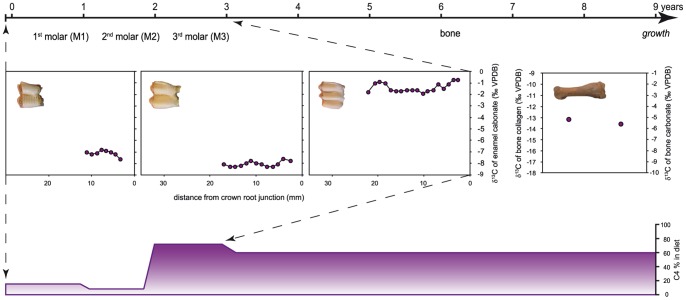
Reconstruction of diachronic changes in the contribution of C4 plants to camelid diet.Dietary contribution of C4 plants over the first years of life of specimen EBE1-1995 and in the long term is estimated by the combined analysis of enamel (δ13Cenamel) from the three molars and the bulk analysis of collagen (δ13Ccol) and structural carbonate (δ13Cbone) from bone.